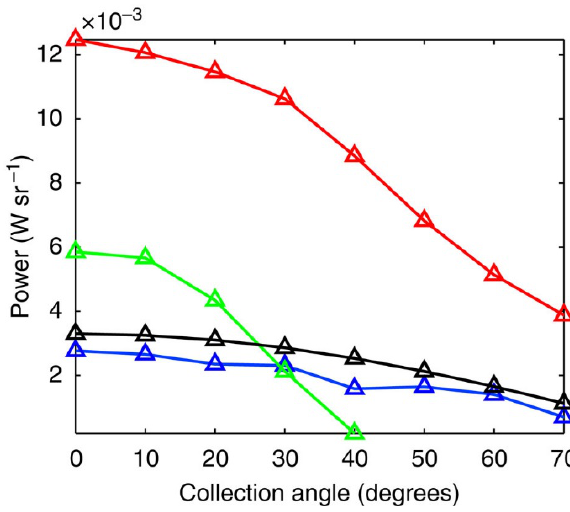
Figure 6: Experimentally measured emission power from the carbon dot as a function of angle. Red and blue is for with and without the ZnSe hemispherical dome in optical contact, respectively. Green is for the case where the flat surface of the dome is separated from the carbon dot by 30 µ m. Triangles are measured data points. The black line is the emission power from an ideal blackbody with the same area as the carbon dot